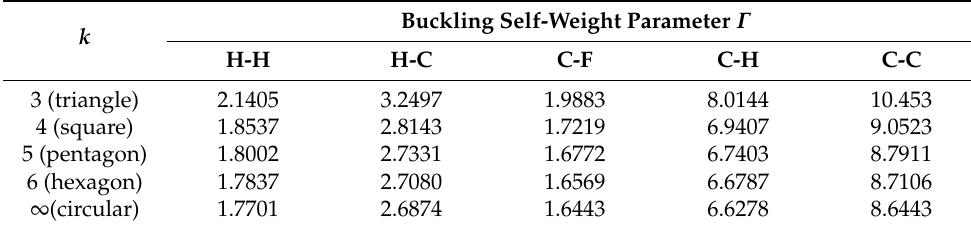
Table 4. Effect of side number k on Γ for n =